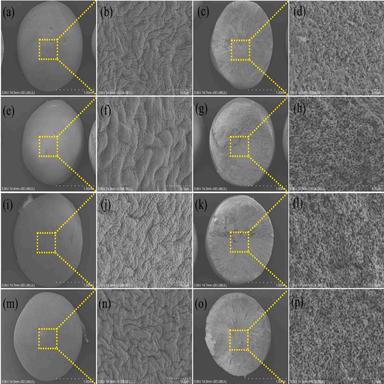
The SEM images of different u-EMFexS (surface: a, b, e, f, i, j, m and n; cross-section: c, d, g, h, k, l, o and p).